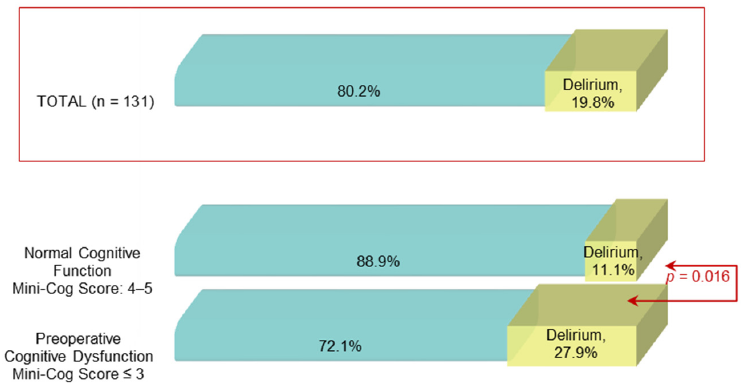
Figure 3. Postoperative delirium prevalence among patients with normal and impaired cognitive function.